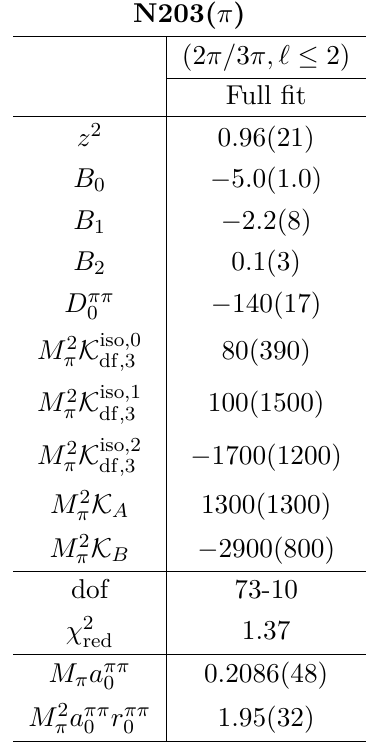
Table 7. Fit for pions on the N203 ensemble including all possible parameters at the order